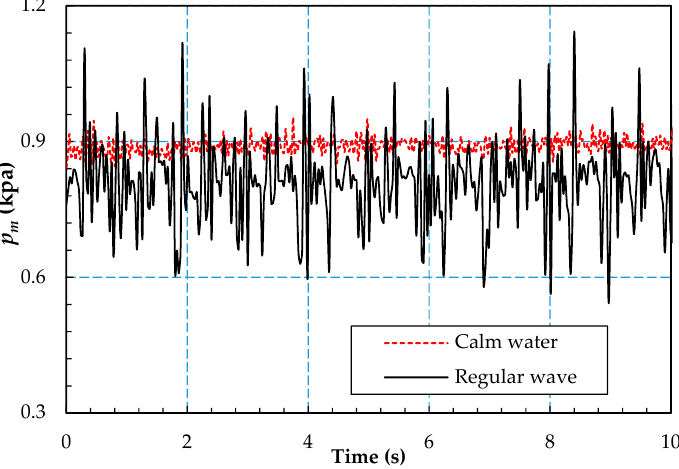
Figure 11. Midship pressure monitored in calm and regular waves.